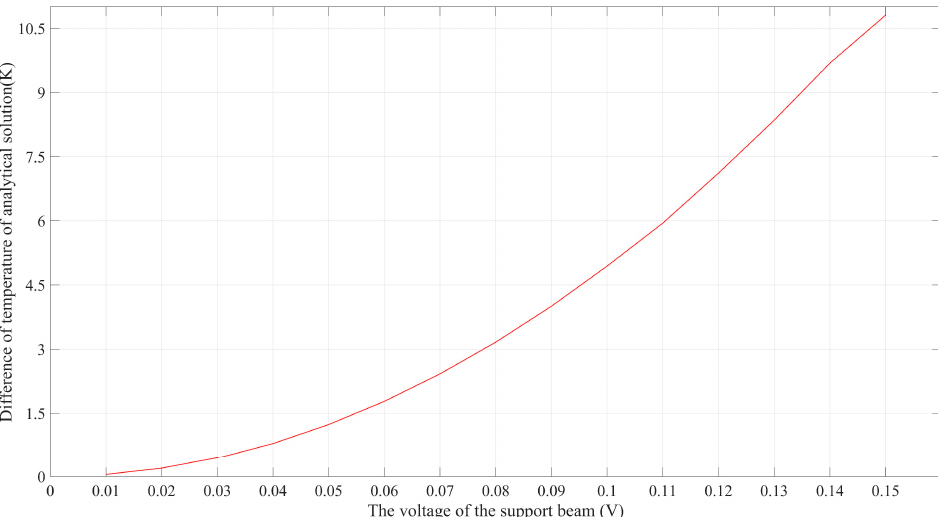
Figure 8. The temperature error between the temperature peak and the temperature at the distal end of supporting beams when di ff erent voltages were applied.